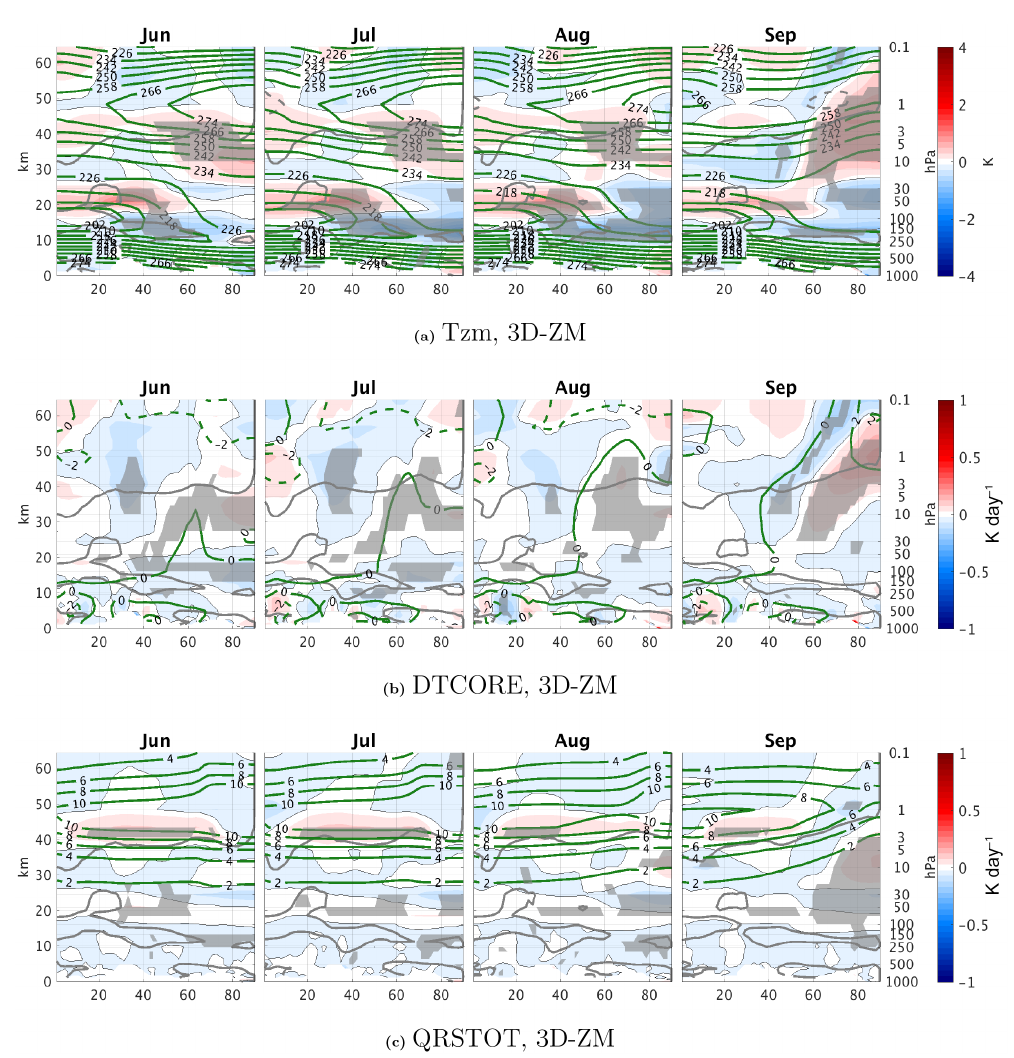
Figure A2. Monthly climatology differences between 3-D and ZM ozone runs during summer, June–September of the zonal mean tempera- ture (a) , zonal mean temperature tendency from dynamics (b) , and shortwave radiation (c) . Statistically significant areas are shown by gray